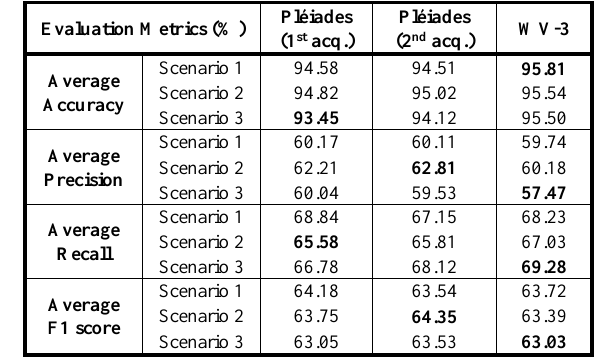
Table 3. Comparison of evaluation metrics for all scenarios. In bold are the highest and the lowest values